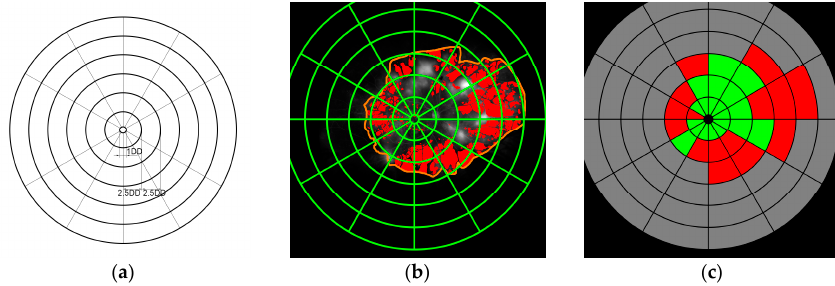
Figure 1. Circular grid assessment of capillary non-perfusion (CNP) dense segmentation. ( a ) Circular grid template; ( b ) Grid on dense segmentation for automatic assessment (perfusion (red), gradable retina (orange)); ( c ) Automated grid assessment (perfused (green), non-perfused (red), ungradable (grey).